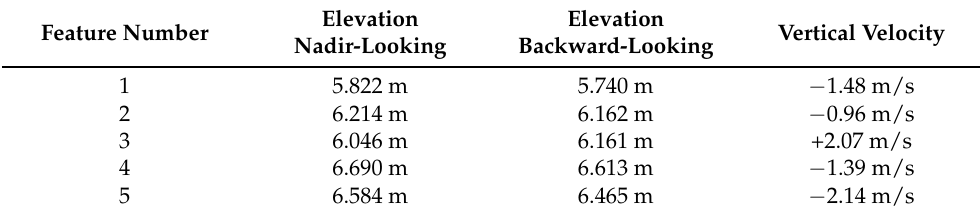
Table 4. Heights and vertical velocities of the features identified in the ash plume of Shiveluch volcano. The time elapsed between nadir- and backward-looking acquisitions was 55.4 s. Feature